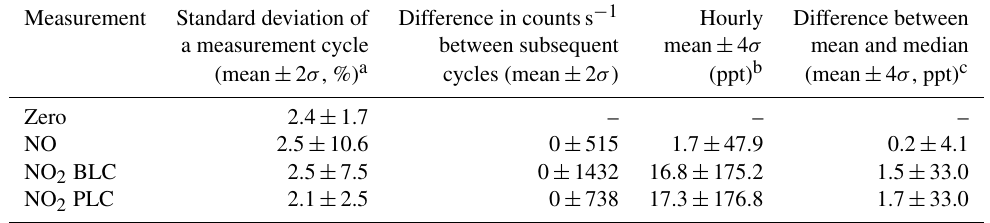
Table 1. Evaluation parameters of the measurements. When a measurement falls outside any of the intervals it will not be used for further data analysis. The mean ± xσ is calculated for 2014–2019 for the zero and NO measurements and 2017–2019 for both NO 2 measurements. Measurement Standard deviation of Difference in countss − 1 Hourly Difference between a measurement cycle between subsequent